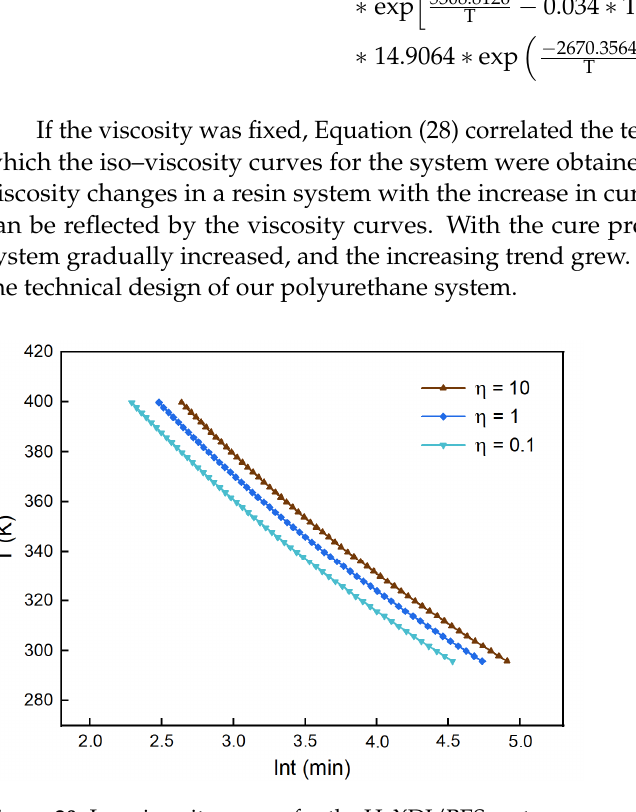
Figure 20. Iso–viscosity curves for the H 6 XDI/BES system. The experimental viscosity values measured at 423 K, 433 K, and 443 K were compared with the theoretical viscosity based on Equation (28), the results of which are shown in Figure 21.